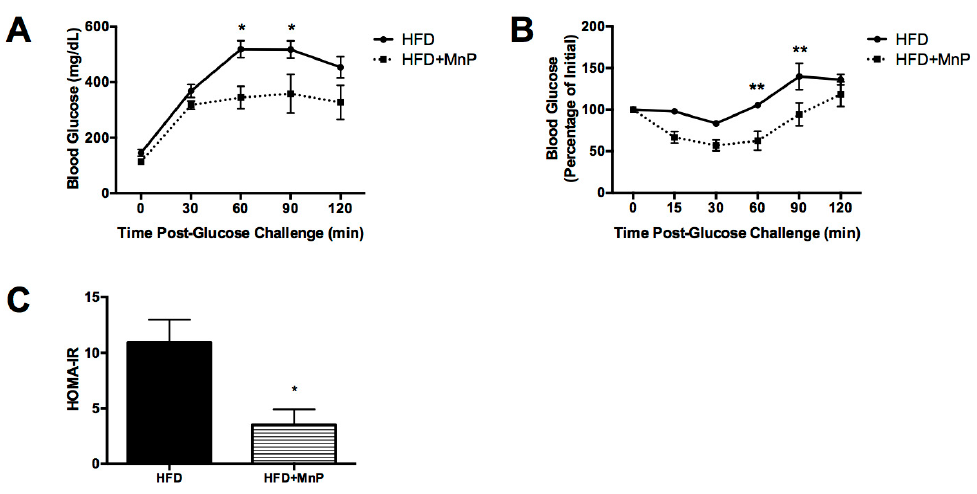
Figure 4. Hepatic insulin resistance is improved with MnP treatment. ( A ) After 10 weeks of HFD feeding, mice were fasted and subjected to an IPGTT. Data are displayed as mean ± SEM. Significance was calculated by two-way ANOVA with a Bonferroni post-test of multiple comparisons. * indicates p ≤ 0.05. ( B ) After 10 weeks of HFD feeding, mice were fasted and subjected to an ITT. Data displayed as mean ± SEM. Significance was calculated by two-way ANOVA with a Bonferroni post-test of multiple comparisons. ** indicates p ≤ 0.01. ( C ) HOMA-IR was calculated from these results. Data are displayed as mean ± SEM. Significance was calculated by t -tests. * indicates p ≤